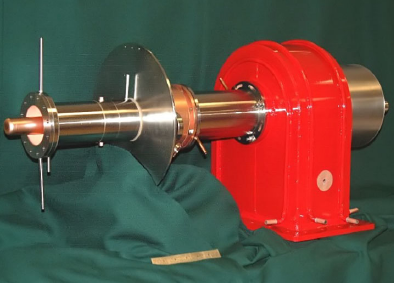
FIG. 19. MW-class, 748 MHz cw coaxial FPC manufactured by CPI (model VWP1185/1186) [37].